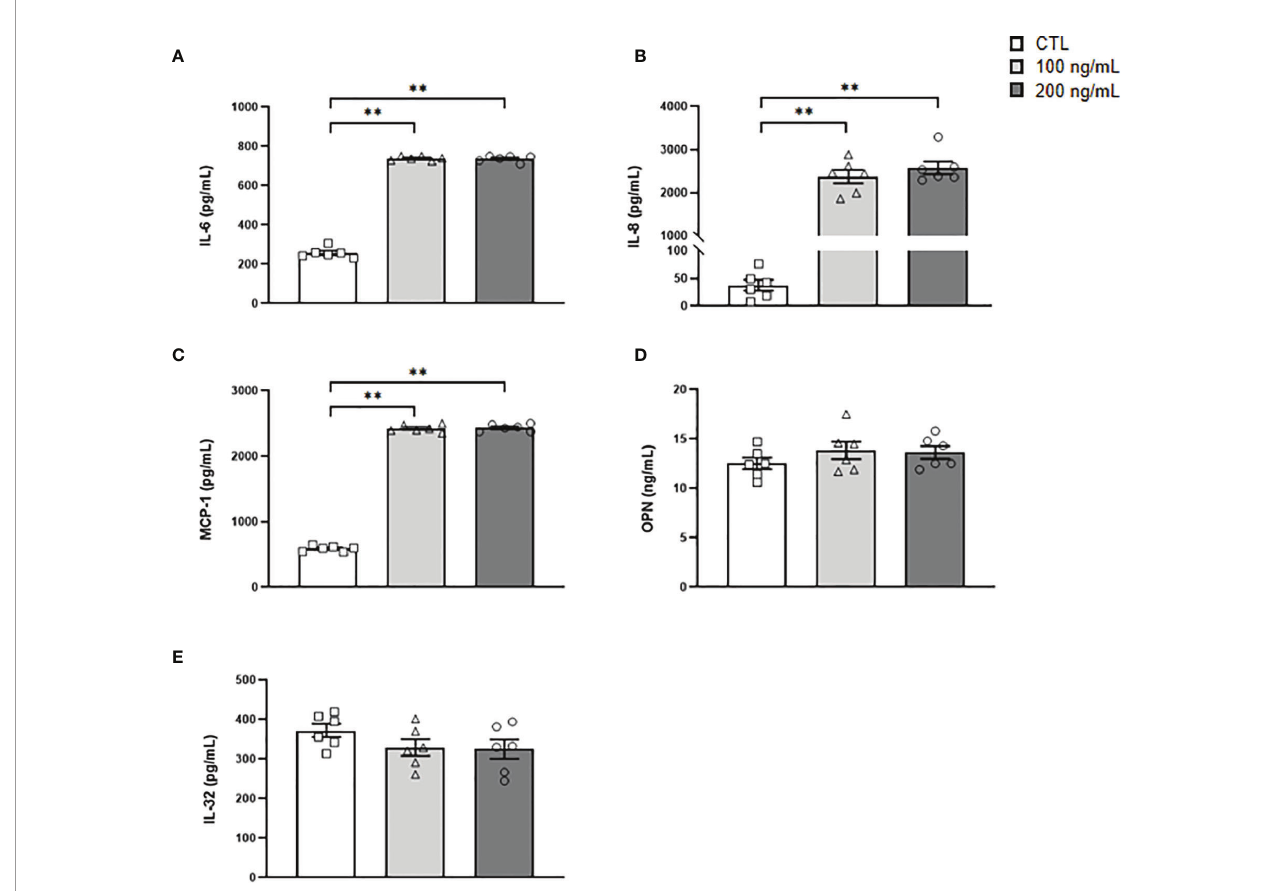
FIGURE 6 | Secreted levels of crucial in fl ammatory markers after IL-36 g treatment. (A) IL-6, (B) IL-8, (C) MCP-1, (D) OPN and (E) IL-32 concentrations in the culture medium of human visceral adipocytes incubated with IL-36 g (100 and 200 ng/mL) for 24 h. Values are the mean ± SEM (n=6 per group). Differences between groups were analyzed by one-way ANOVA followed by Tukey ’ s tests. ** P <